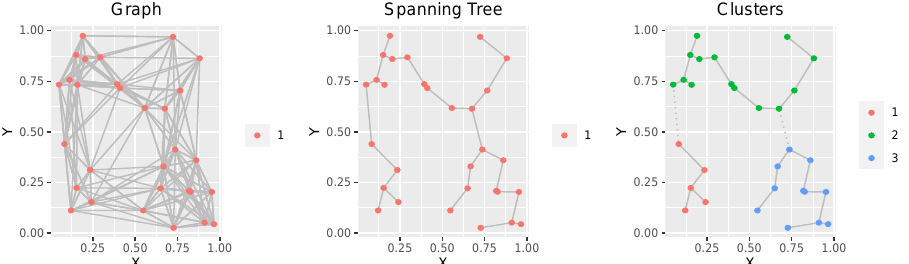
Figure A1. Left panel: A connected graph G of 30 nodes, where each node is connected with its 10 nearest (according to Euclidean distance) neighbors, and edge weights are equal to the Euclidean distances between the nodes. Middle panel: The minimum spanning tree of G . Right panel: The three induced clusters by removing two edges of the spanning tree (the two dotted